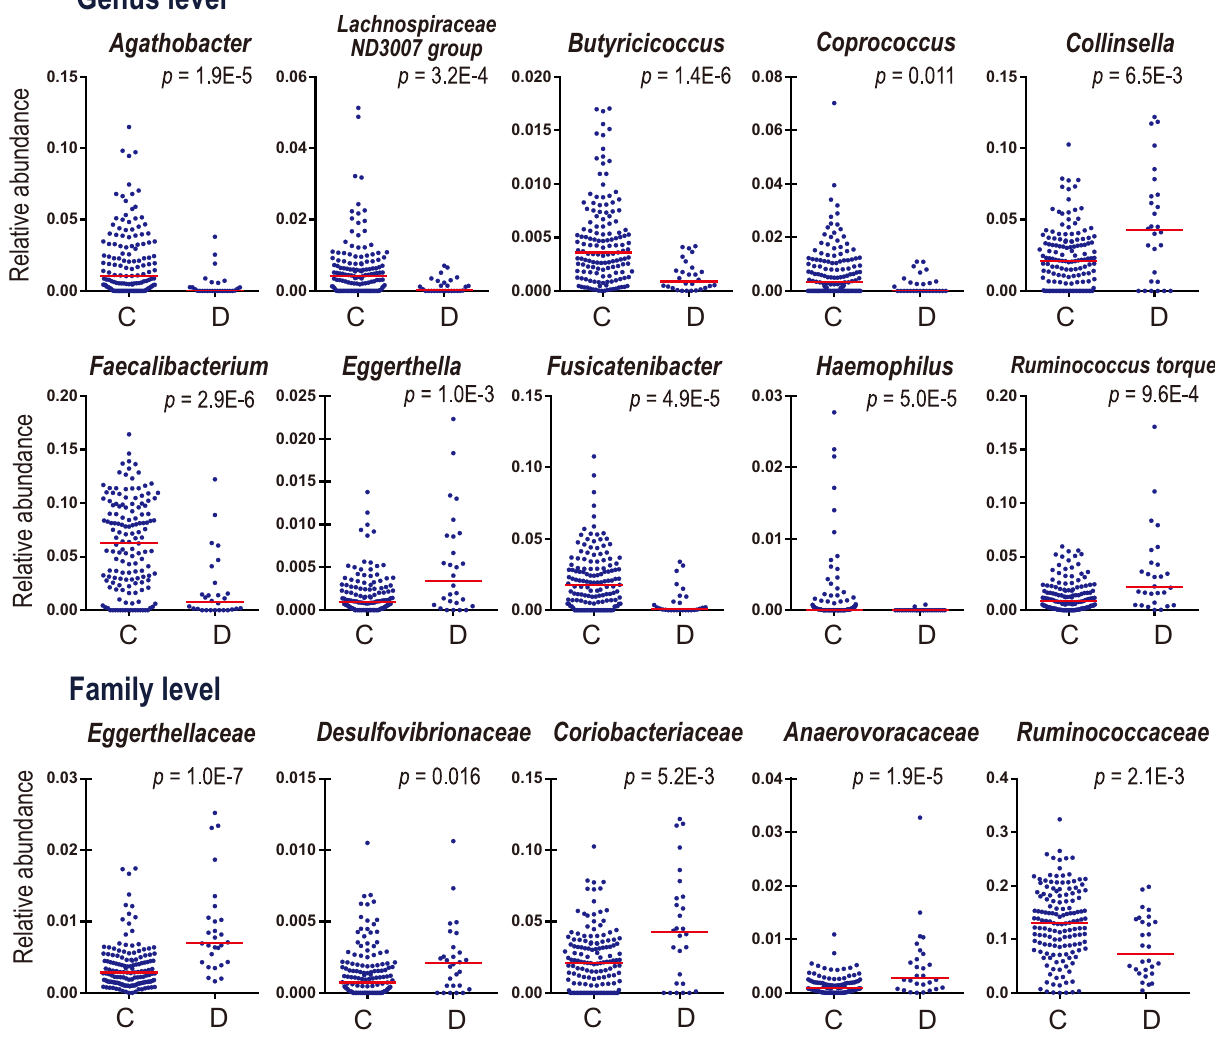
Fig. 1 Plots of ten genera and fi ve families that were signi fi cantly changed between controls (C) and DLB (D). Medians are indicted by red bars. P -values are calculated by Wilcoxon rank sum test. Q -values by the Benjamini-Hochberg method are indicated in Supplementary Table 2a at the genus level and 2b at the family order to identify bacteria that were uniquely changed in DLB, we made random forest models to differentiate DLB ( n = 28) and HY3&4 ( n = 91) (including both PDD − and PDD + ), as well as AUROC to differentiate DLB and HY3&4 was 0.756 (95% con fi dence interval: 0.649 – 0.864) (Fig. 3a) by nested cross-